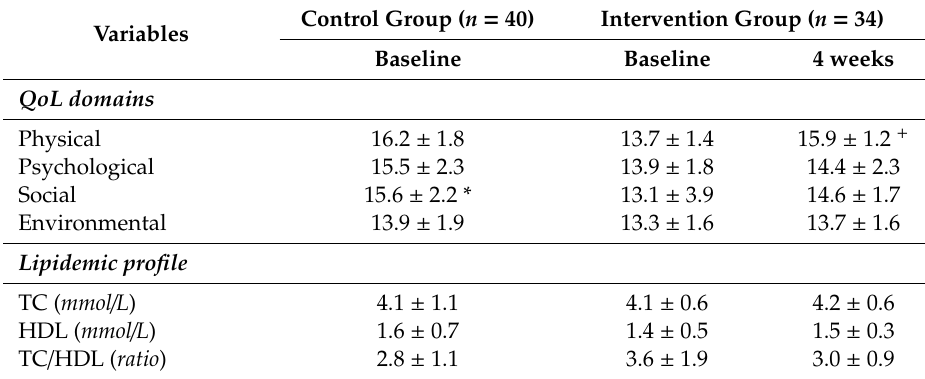
Table 5. Quality of life and Lipidemic profile of participants in both groups (mean ±